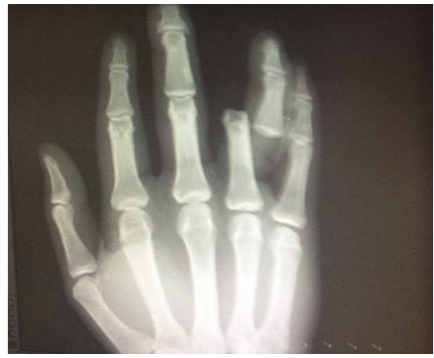
Figure 3: X-ray showing finger dislocation.